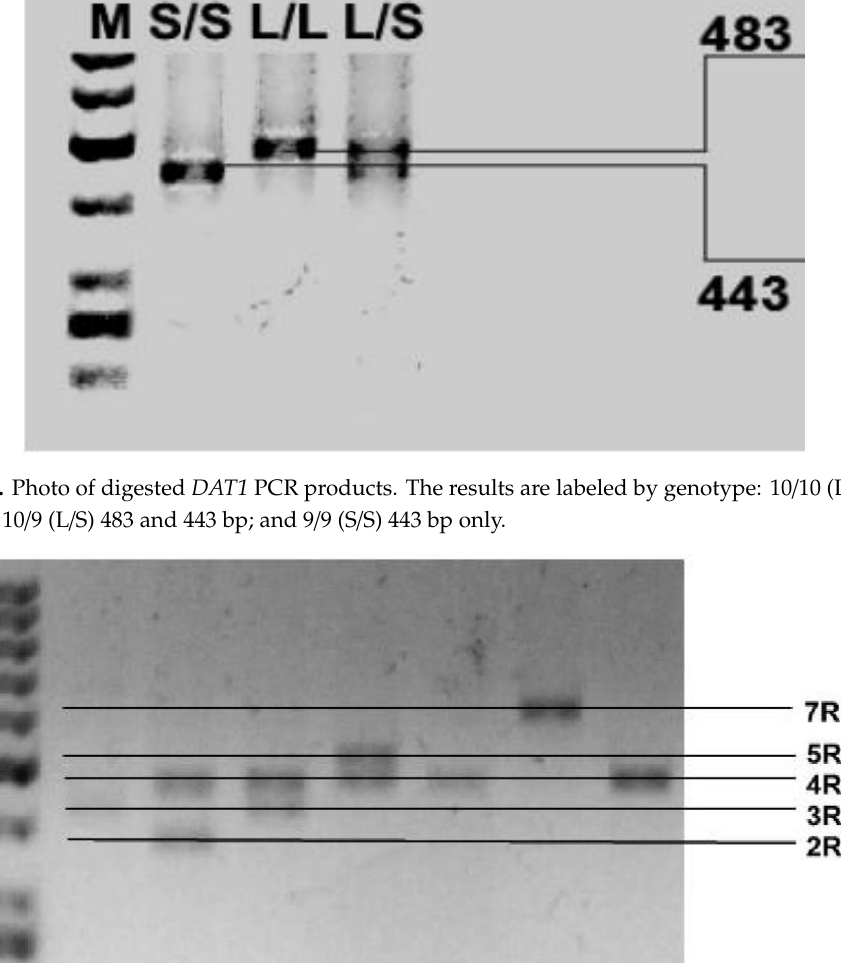
Figure 1. Photo of the digested COMT PCR products. The results are labeled by genotype: Met/Met (A/A), 96 bp only; Val/Met (A/G) 114 and 96 bp; and Val/Val (G/G), 114 bp only.